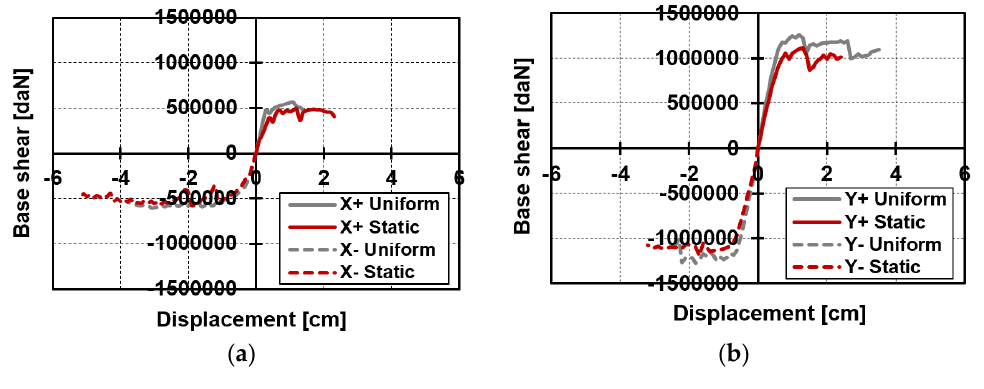
Figure 8. Capacity curves in ( a ) ±X and ( b ) ±Y directions.